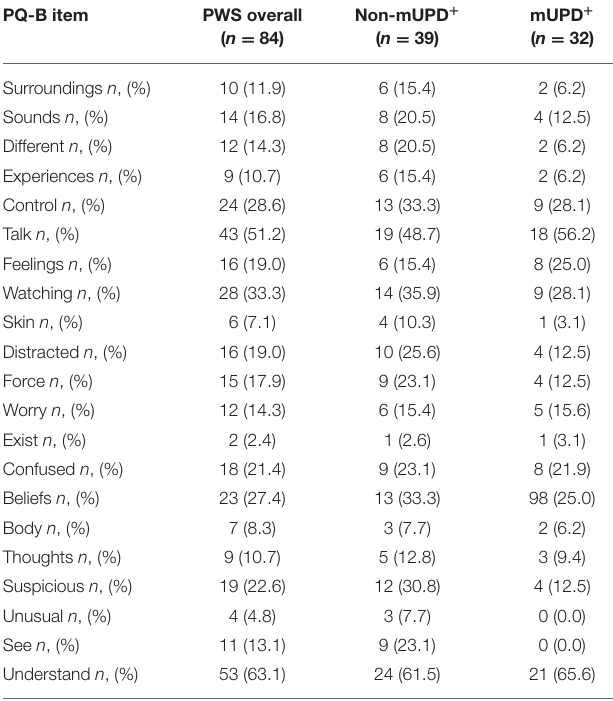
with and without a mUPD mutation. PQ-B item